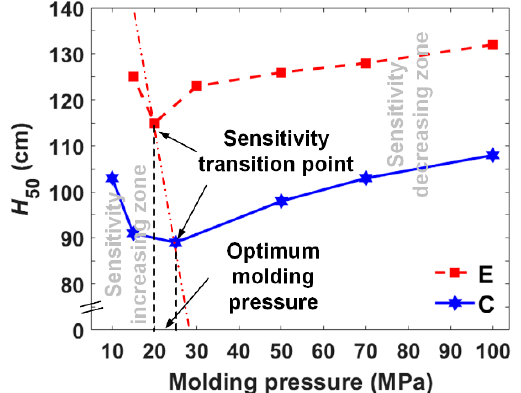
Figure 13. Relationship between the characteristic drop height ( H 50 ) and molding pressure of the type C and type E PTFE/Al/W reactive material.